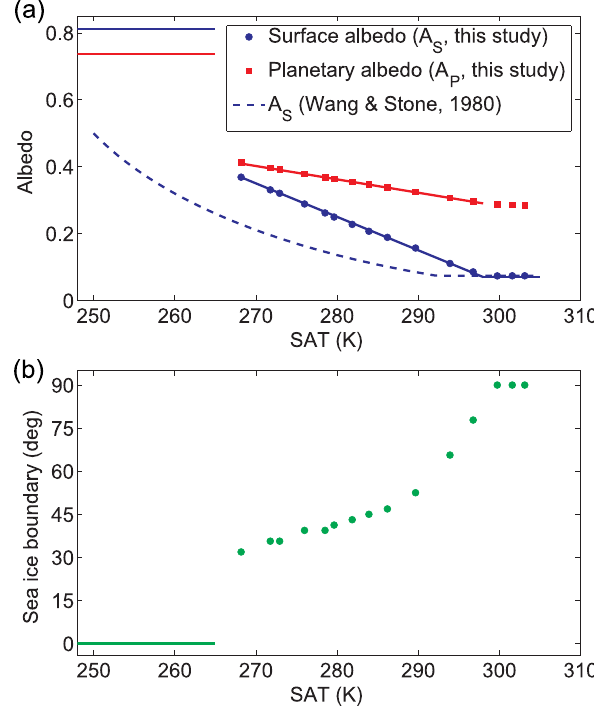
Fig. 21: Dependency of (a) surface and planetary albedo as well as (b) sea-ice boundary (mean of Northern and Southern Hemisphere values) on global mean SAT. The linear fits in panel (a) correspond to Eqs. (5) and (6). The constant albedo values for extremely low temperatures originate from a simulated snowball state. The dashed blue line in panel (a) shows the temperature dependence of the global mean surface albedo for present-day conditions according to Wang and Stone (1980) under the assumption of our snow and ocean albedo values.